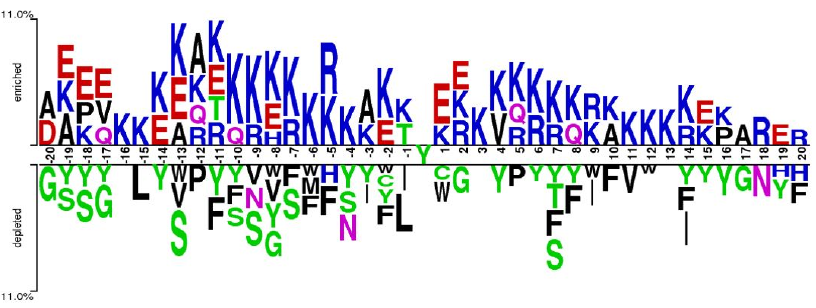
Figure 2. Sequence preference analysis of positive and negative samples of nitroproteins.